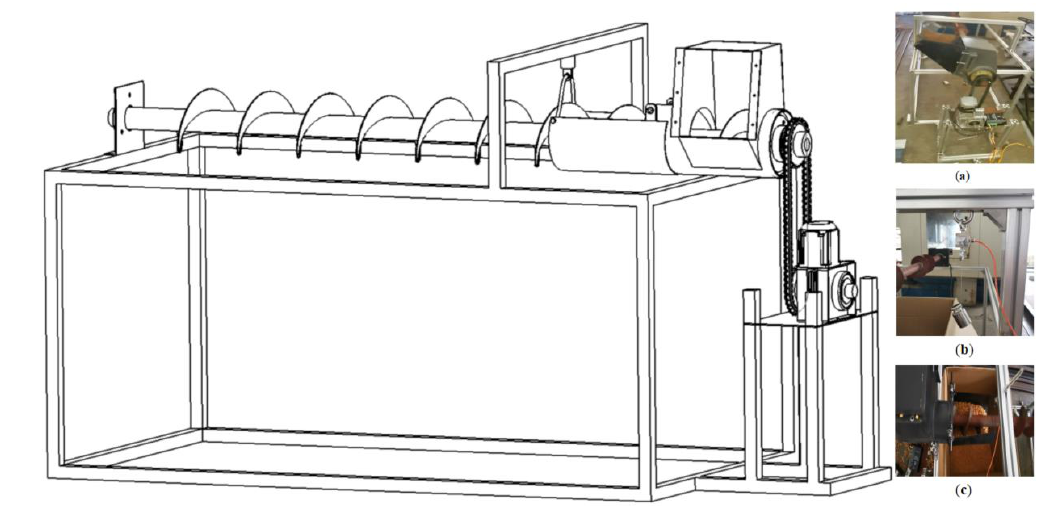
Figure 10. Test bench for weighing method of yield measurement. ( a )actual view of the bench;( b ) load cell calibration; ( c )weighing method yield test. Table 2. Comparison of test